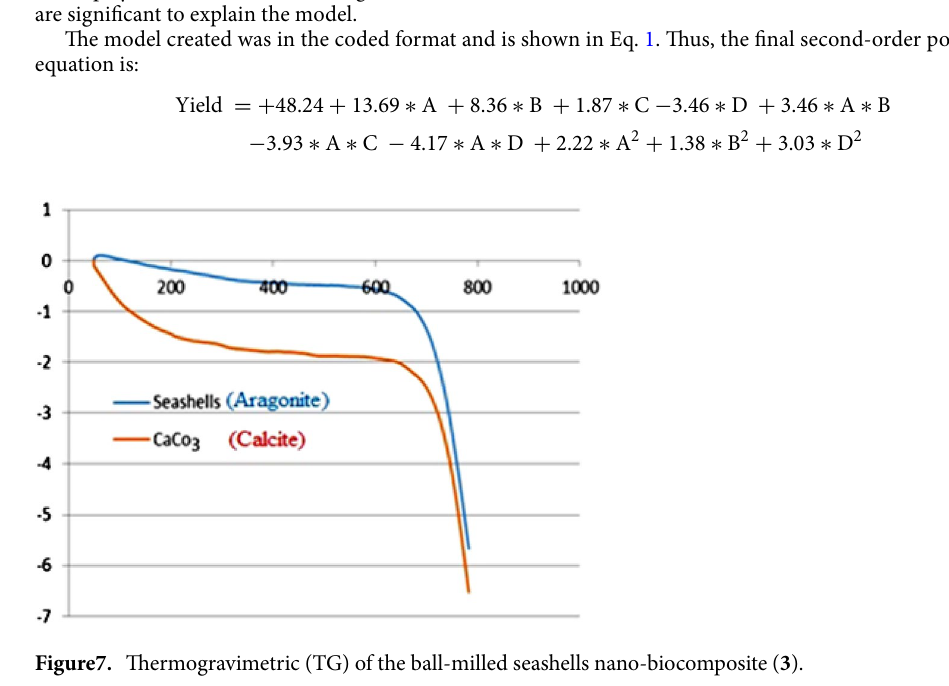
Figure7. Thermogravimetric (TG) of the ball-milled seashells nano-biocomposite ( 3 ).